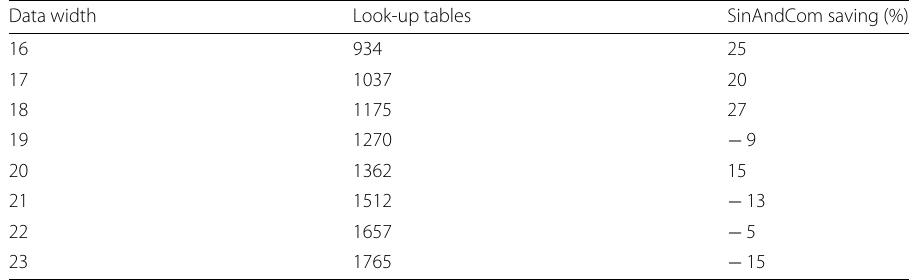
Table 9 Resource utilization of the CORDIC generators Data width